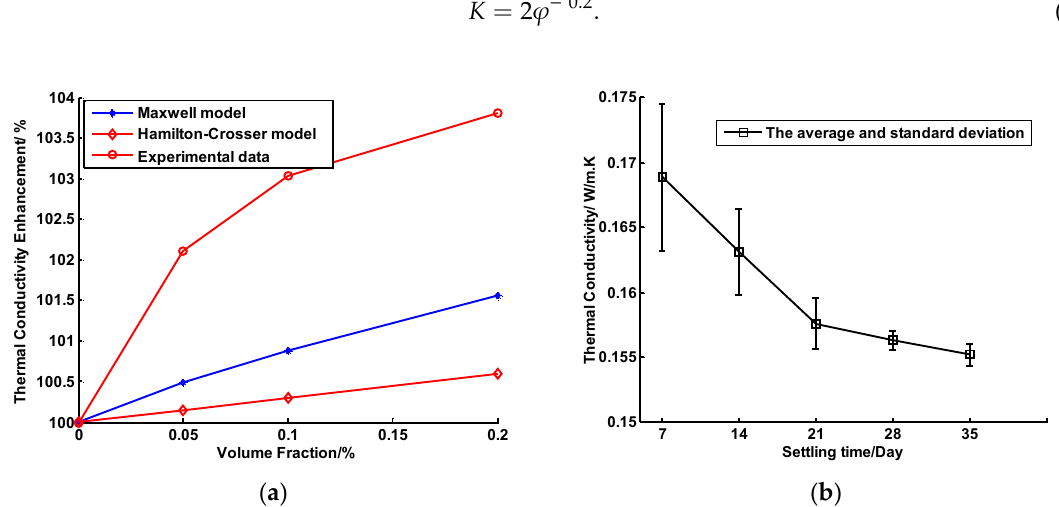
Figure 11. ( a ) Theoretical and tested values of thermal conductivities of nanofluids as a function of volume fraction. ( b ) Thermal conductivity of nanofluids as a function of settling time.